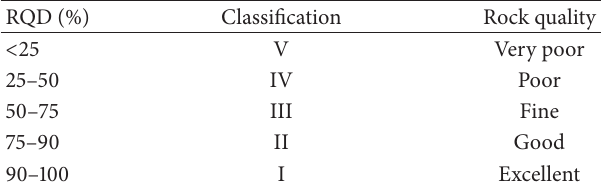
Table 1: Classification criterion of rock quality by the RQD [26,